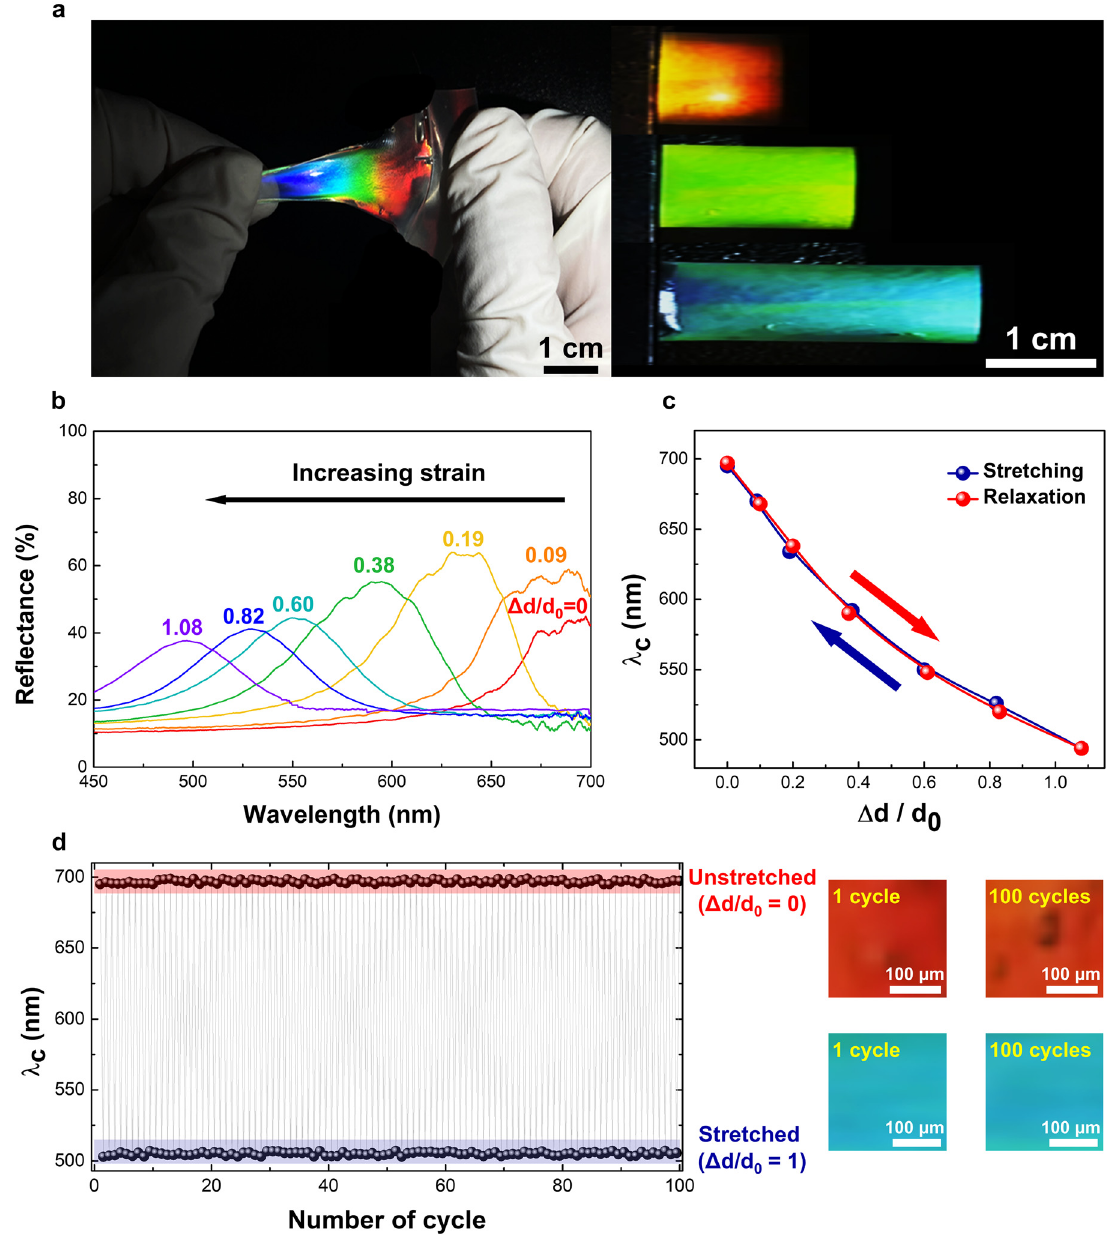
Figure 3: Mechano-optical changes in the properties of CPGs: (a) reflective color change in CPG samples by mechanical stretching; (b)photonicwavelengthblue-shiftasafunctionoftheaddressedmechanicalstrain;(c)reversiblecentralphotonicwavelength( λ c )changesas a function of stretch power ( Δ d / d 0 , where ‘ Δ d ’ is the stretched scale of length and ‘ d 0 ’ is the initial sample length); and (d) repeatable and recovered wavelength control of mechanicallystretchedCPGs up to 100 stretching – relaxation iteration cycleswith 100% further stretching of the suf fi cient electric fi eld strength required to overcome the threshold electric fi eld was ∼ 15 V/ μ m because of the elastic storing energy of dielectric soft actuator and CPGs.